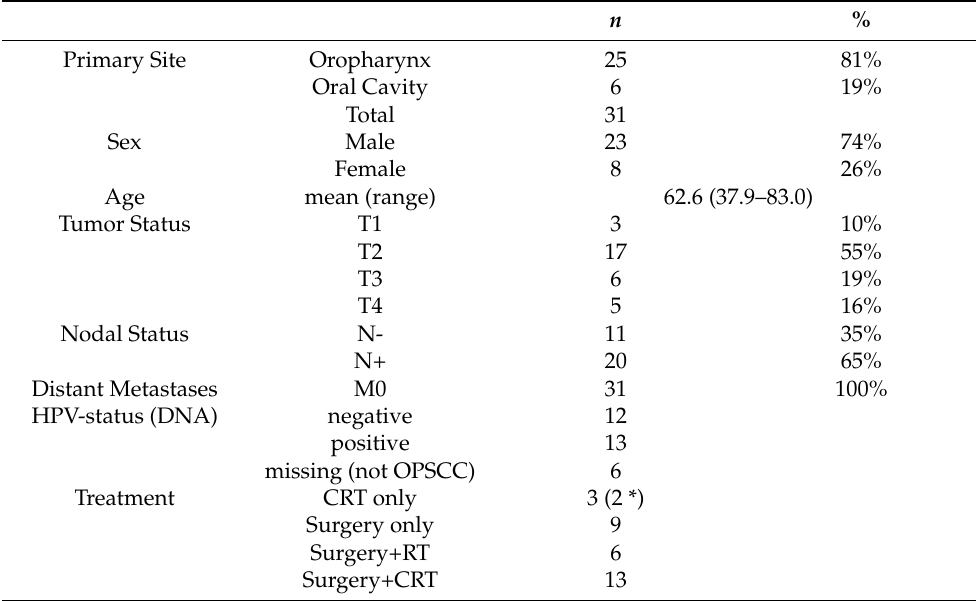
Table 2. Summarized patient